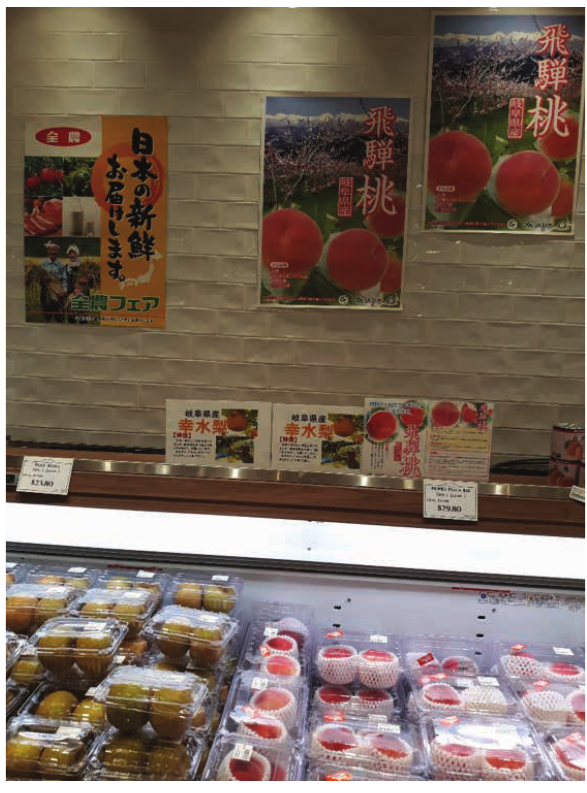
Figure 8: Carefully packaged fruit: Kōsui-nashi (Kosui pears) and Hida-momo (Hida peaches)